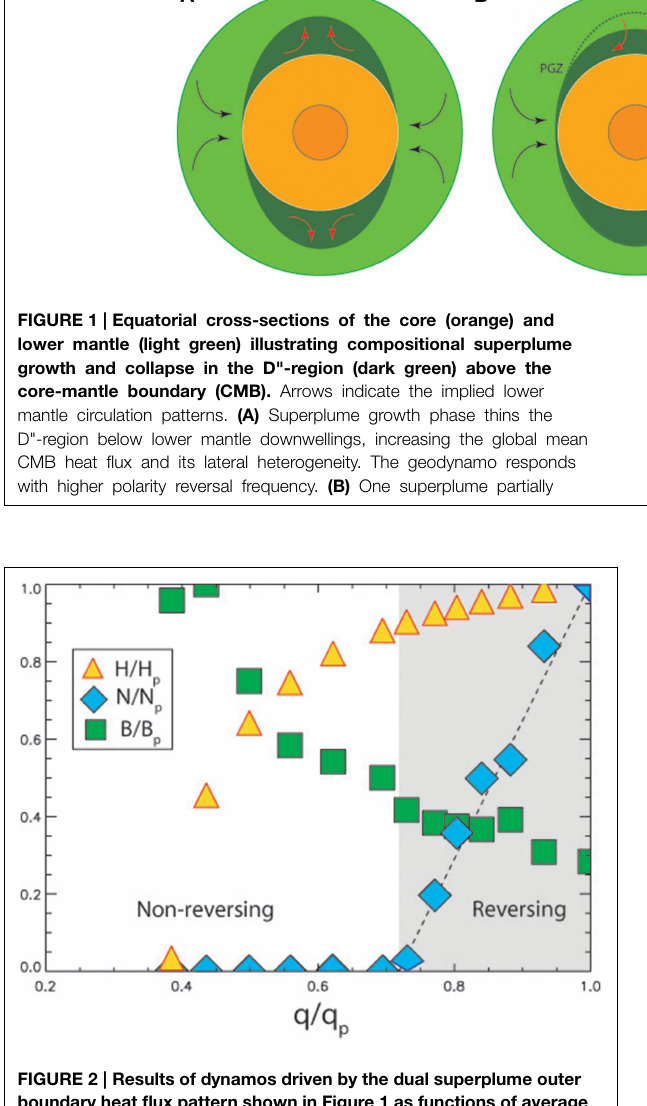
FIGURE 2 | Results of dynamos driven by the dual superplume outer boundary heat flux pattern shown in Figure 1 as functions of average boundary heat flux q . H is superplume height, N is polarity reversal frequency, B is dipole field intensity. All variables are normalized by their present-day values, denoted by subscripts p . Polarity reversing dynamo regime is denoted by shading. Dashed line shows linear fit between N / N p and q / q p in the reversing dynamo